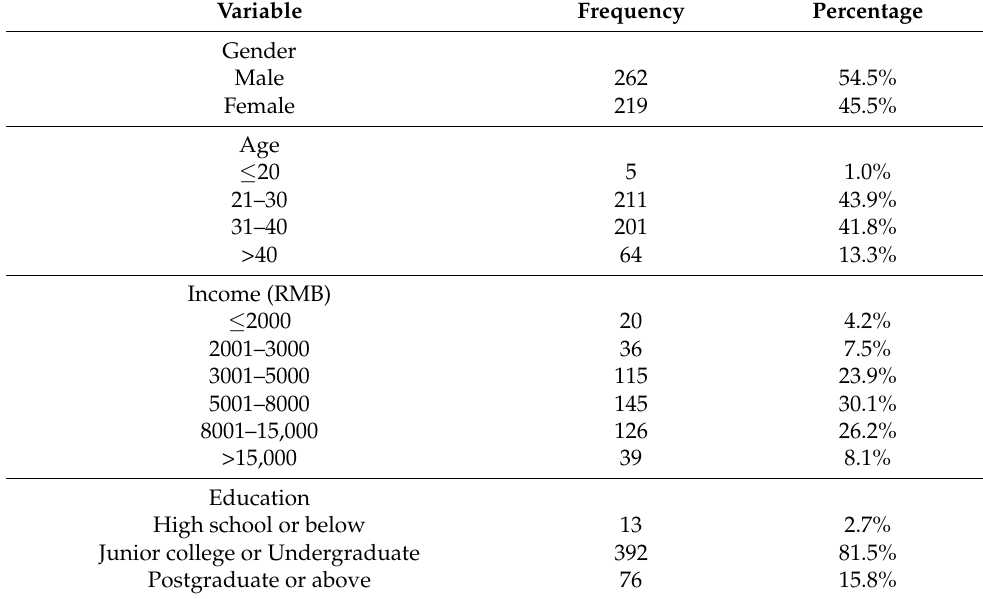
Table 1. Demographic